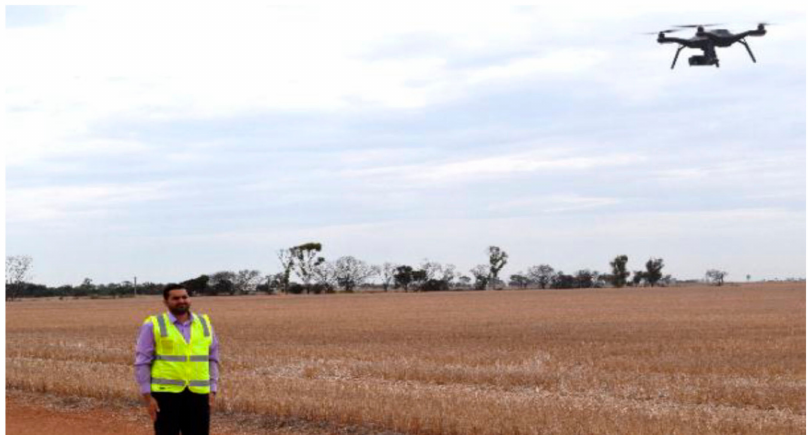
Figure 9. Data collection using a UAV (3DR solo drone)